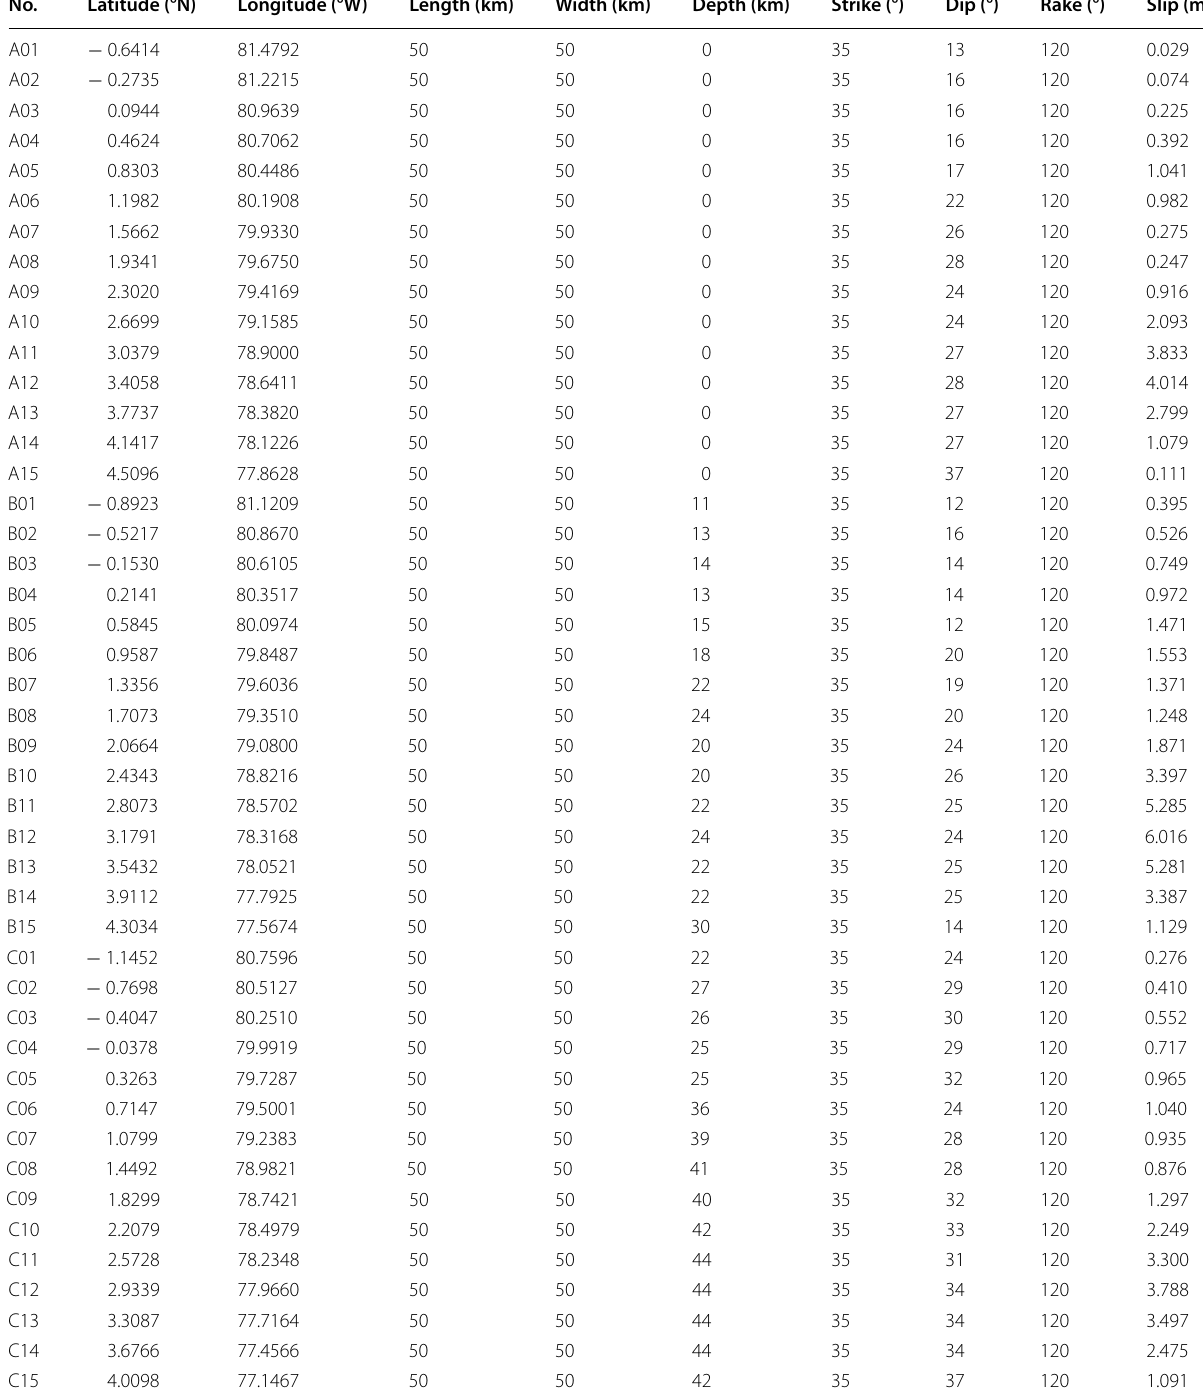
The latitude and longitude indicate the left corner and top dip of each subfault. The depth is the distance from the seafloor to the top dip